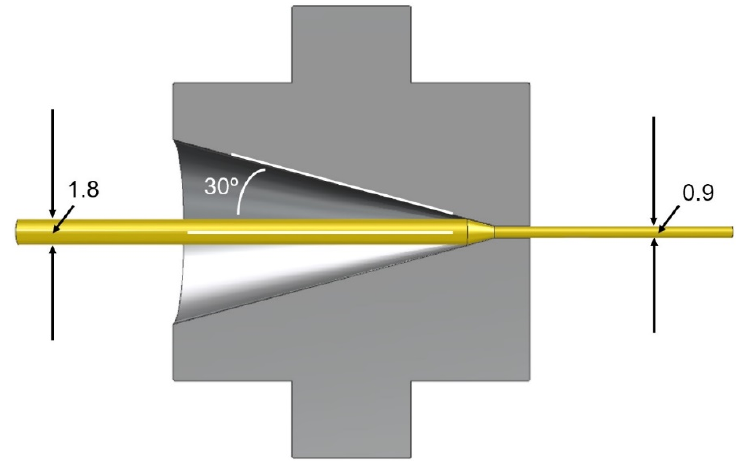
Figure 1. Cross-section of die with oriented fibre emerging on the right. Dimensions in mm. Figure 1. Cross ‐ section of die with oriented fibre emerging on the right. Dimensions in mm.